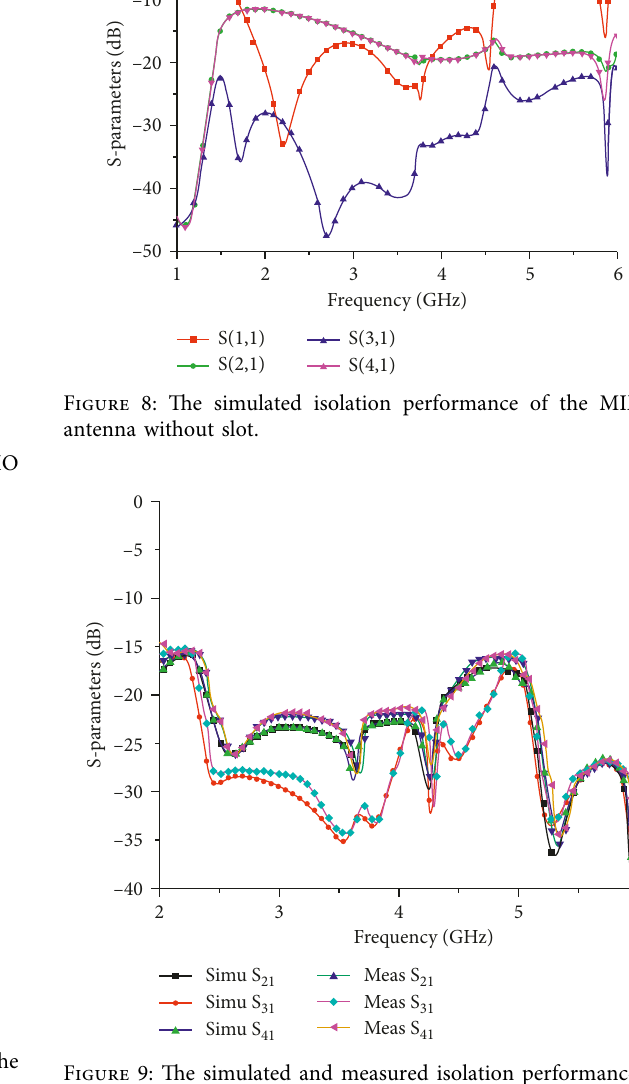
four inverted-F radiation elements, four feed ports, and a coplanar ground plane. The antenna is printed on the FR4 substrate with a dielectric constant of 4.4, a thickness of 1.6 mm, and a loss tangent of 0.025. The thickness of covered copper layers is 35 um. A set of interdigital gap is etched on